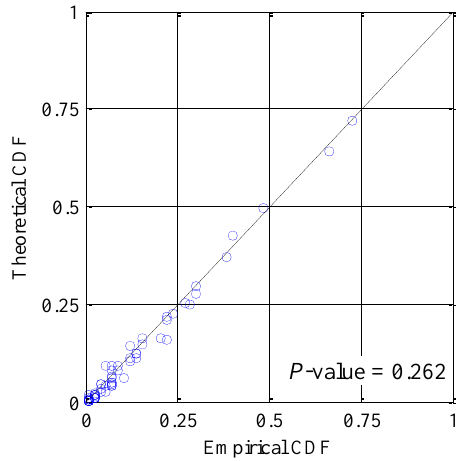
Figure 6. Q – Q plot of empirical and theoretical CDFs of sub- regional precipitation using the eight-dimensional Gaussian copula.